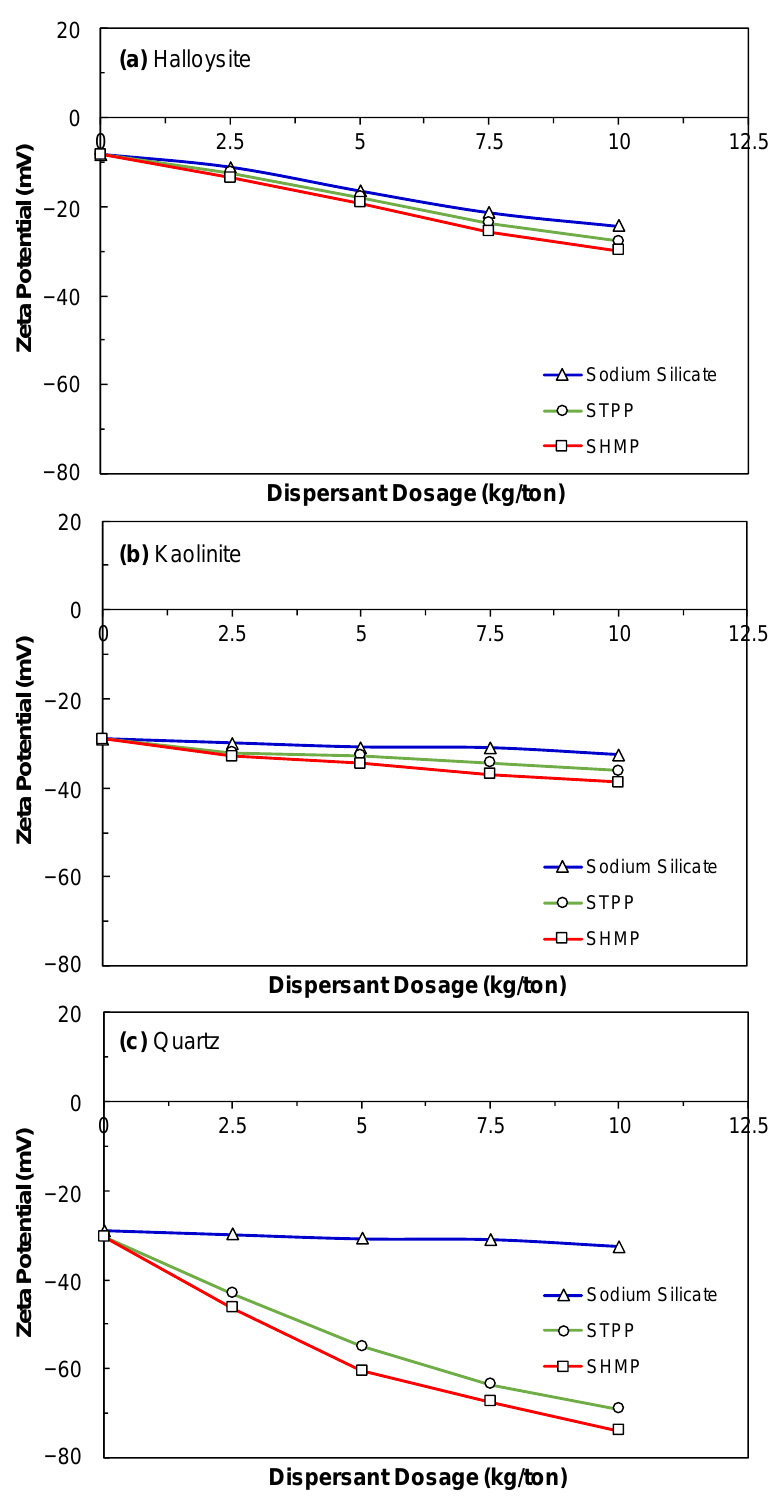
Figure 6. Zeta potential change of ( a ) halloysite, ( b ) kaolinite, and ( c ) quartz minerals in the presence of different dispersants at natural pHs (3.8, 6.2, and 6.7, respectively) and room temperature. In sodium silicate, STPP, and SHMP systems, sodium ions take calcium counter ions’ place within the electrical double layer in kaolinitic clay suspensions [34]. Since halloysite,